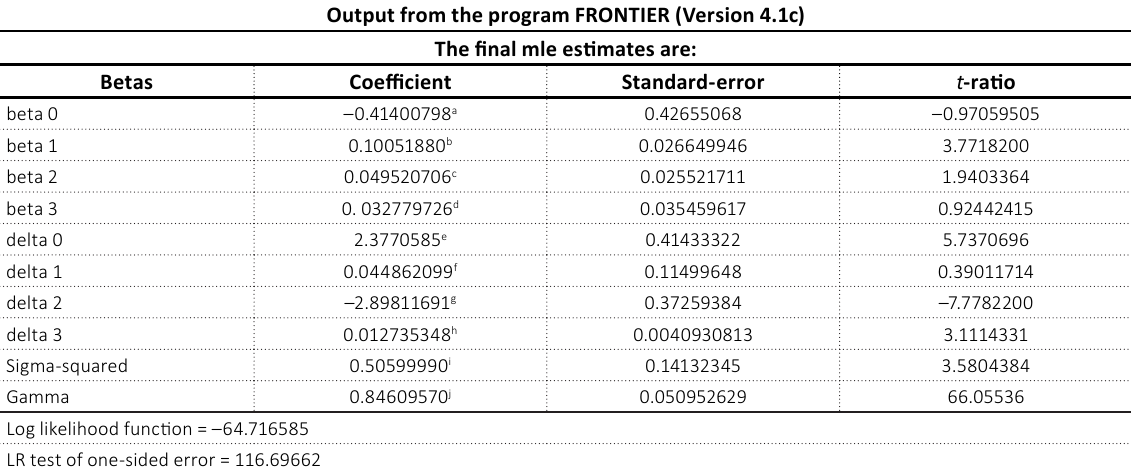
Table 2. Result of the stochastic frontier panel estimation on funds efficiency, defined by Equations (11) and